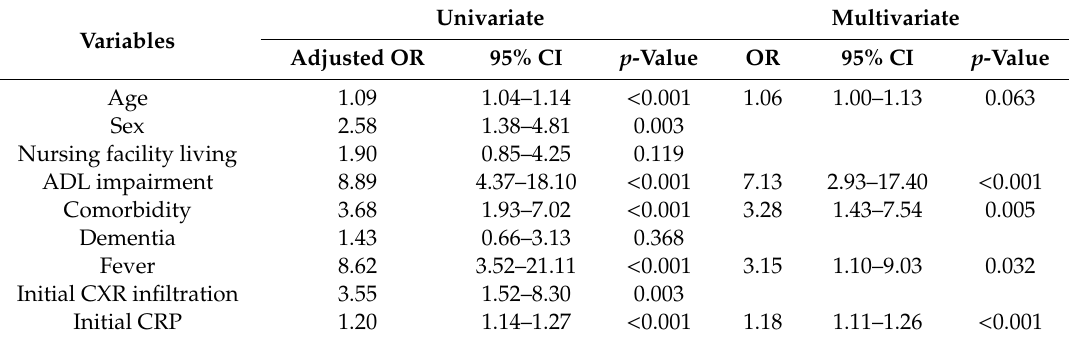
Table 4. Univariate and multivariate logistic regression analysis of predictive factors for death with